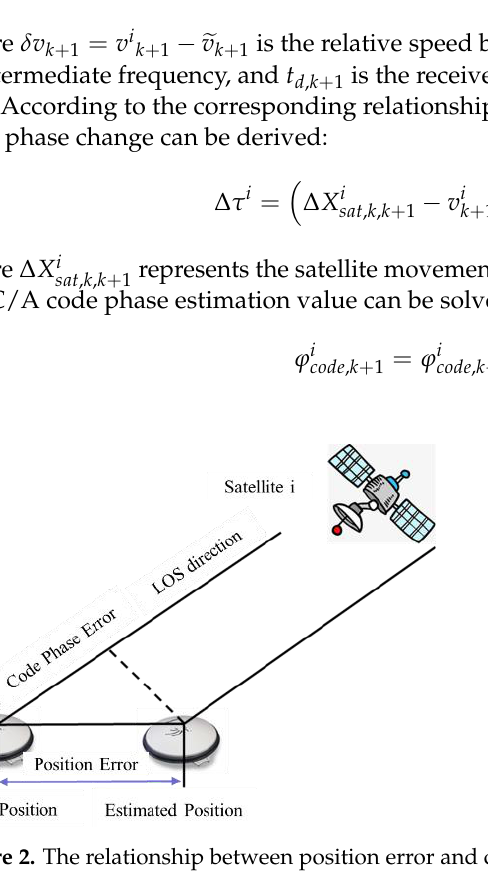
2.31 Figure 4. The positioning results in the static test in a Google map.